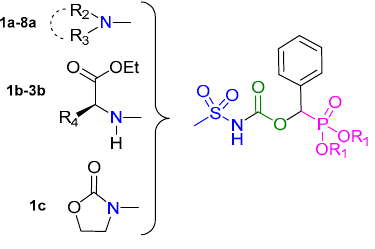
Figure 3. General formula of studied compounds.